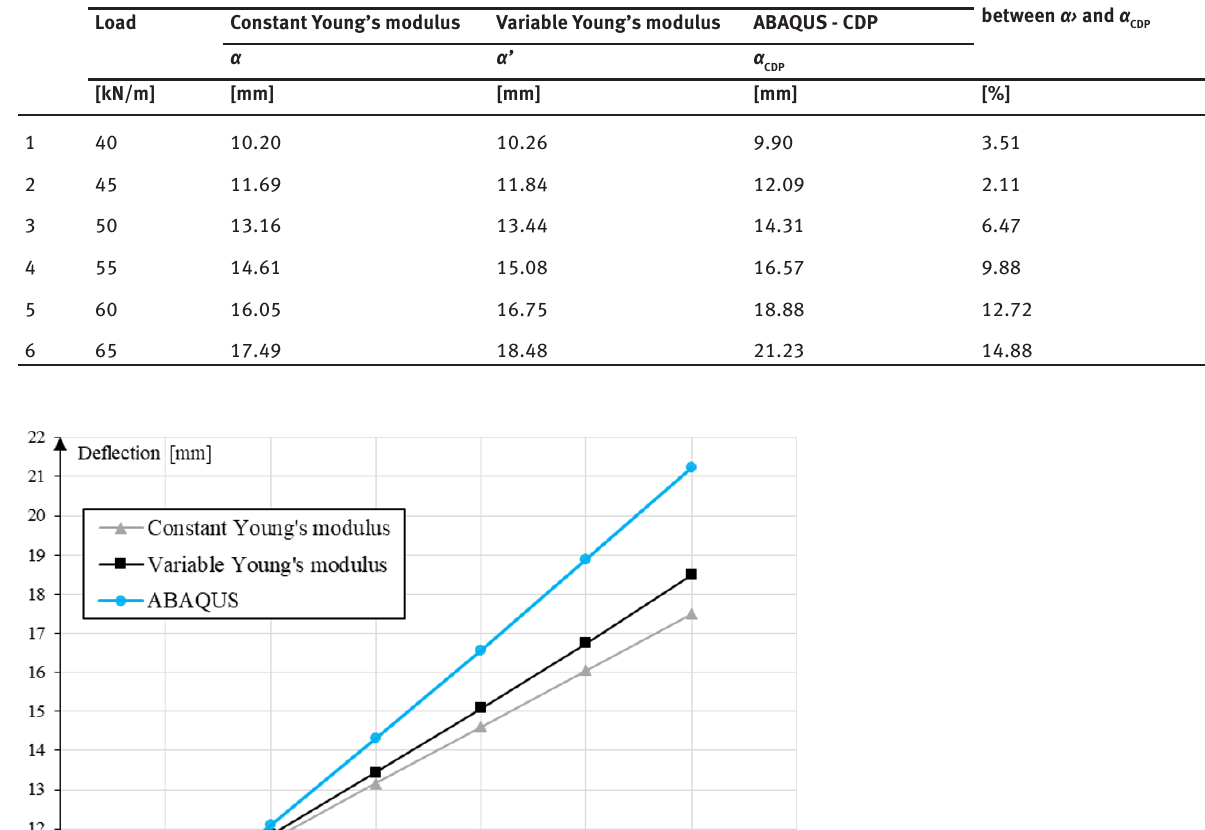
Table 3: Comparison of deflections for bar model and FEM model. No. Bar model